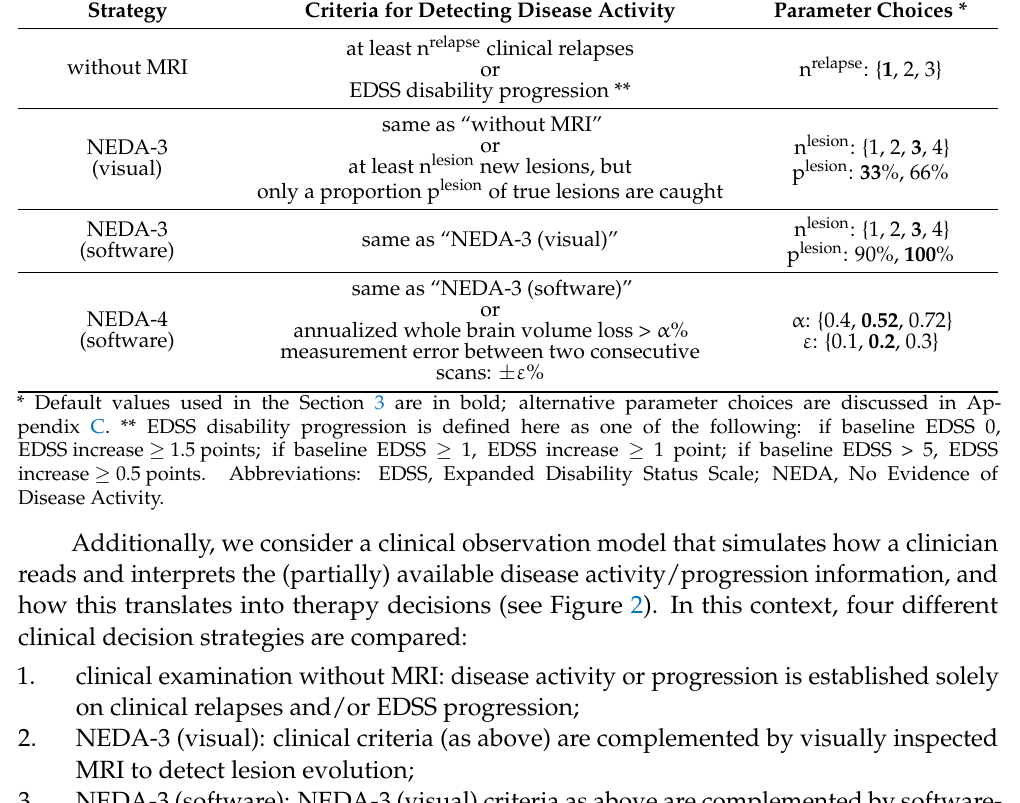
Table 1. Observation strategies and choice of decision parameters. Strategy Criteria for Detecting Disease